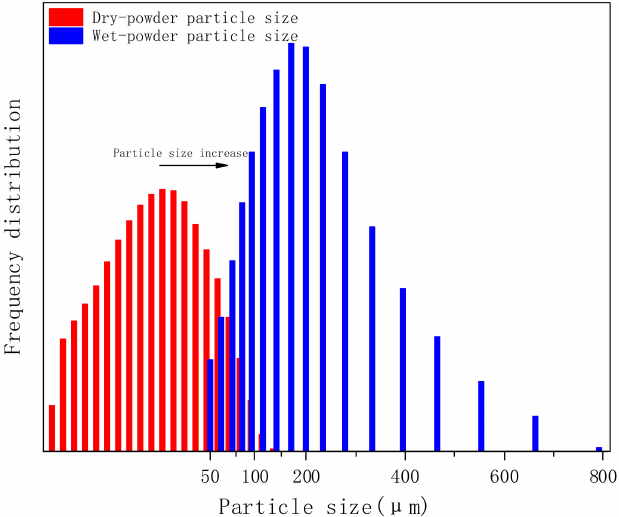
Figure 7. Particle size distribution of PVA-AA-t before and after